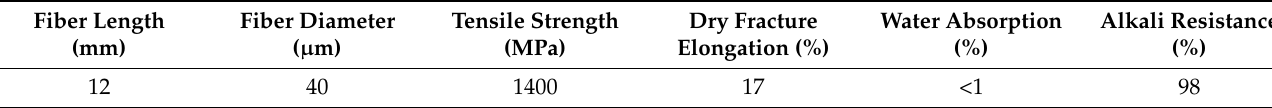
Figure 1. Morphology of fly ash. Table 2. Physical parameters of PVA fiber [38].